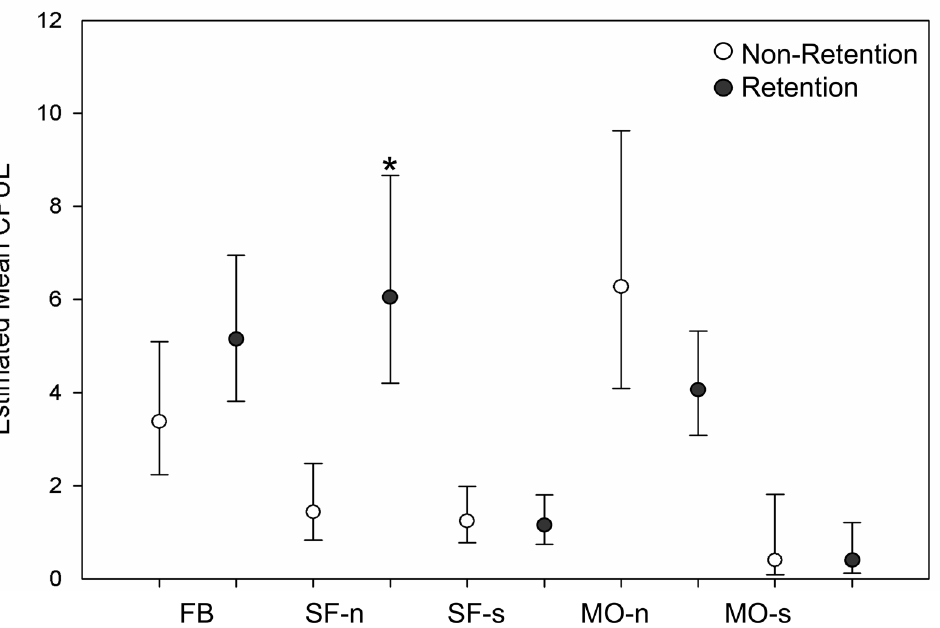
Fig 3. Mean catch per unit effort (CPUE, vessel-day fishing effort) for non-retention and retention fisheries sampling. CPUE was compared within each of five sampling areas: Fort Bragg (FB), San Francisco north (SF-n) and south (SF-S), Monterey north (MO-n) and south (MO-s). For FB, the June/non- retention fishery was compared to the July/retention fishery. For remaining areas, the July 1 – 4 and 8 – 11 retention fishery was compared to non-retention sampling conducted over the remainder of July. Mean CPUEs and 95% confidence intervals were calculated using a log-linear negative binomial model. The null hypothesis of no difference between CPUE for retention fishery is rejected at a probability of z > .0.5, denoted by *